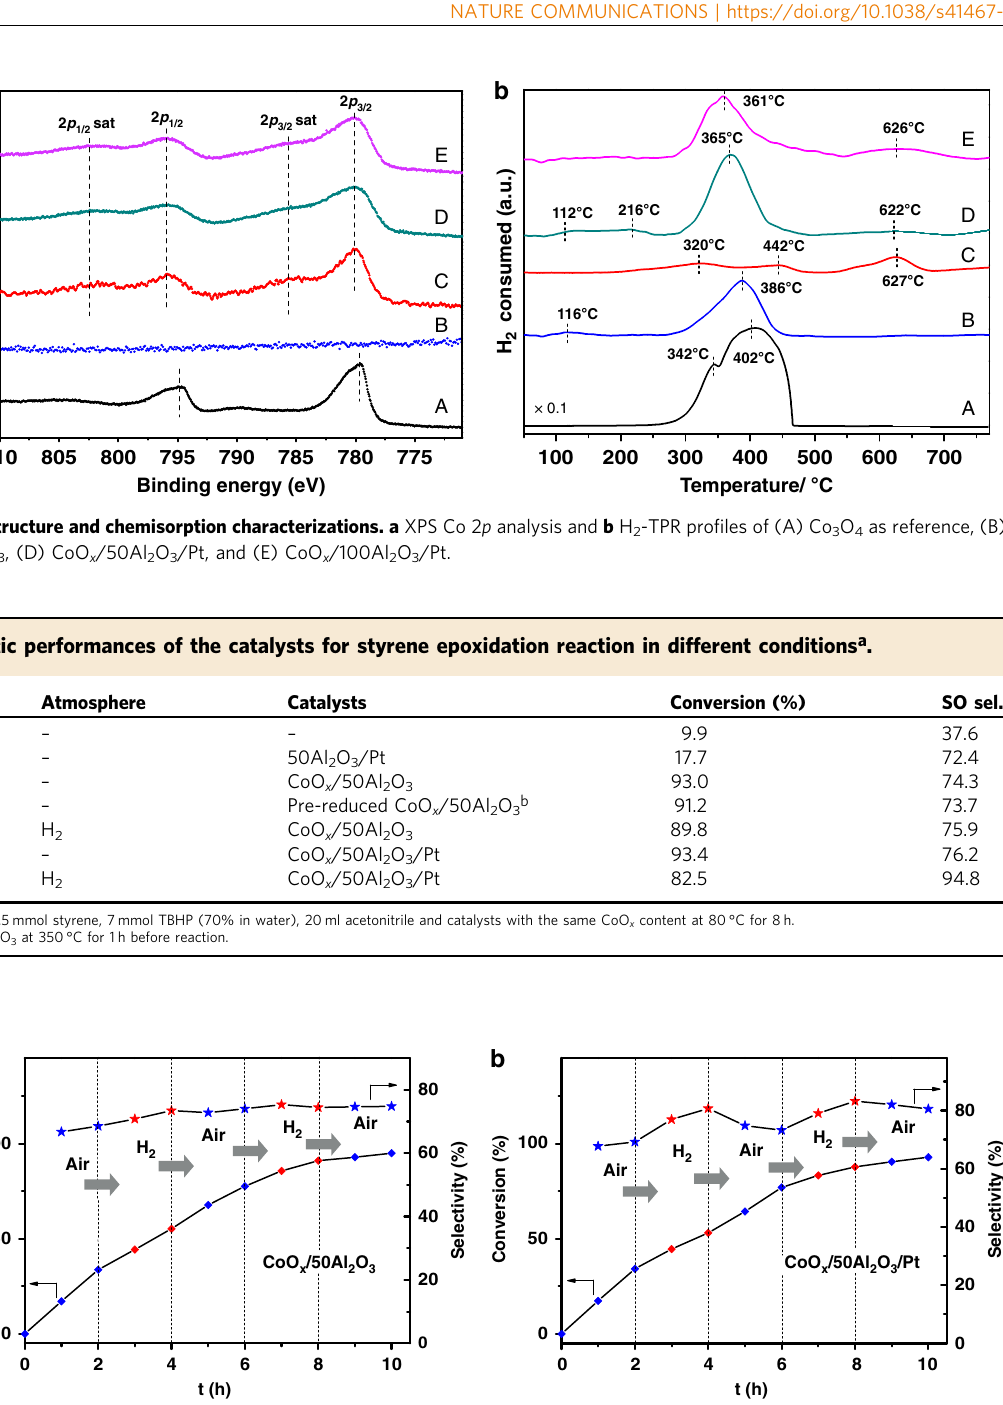
Fig. 4 H 2 pulse experiments. The evolution of styrene conversion and SO selectivity with reaction atmosphere and time over a CoO x /50Al 2 O 3 and b CoO x /50Al 2 O 3